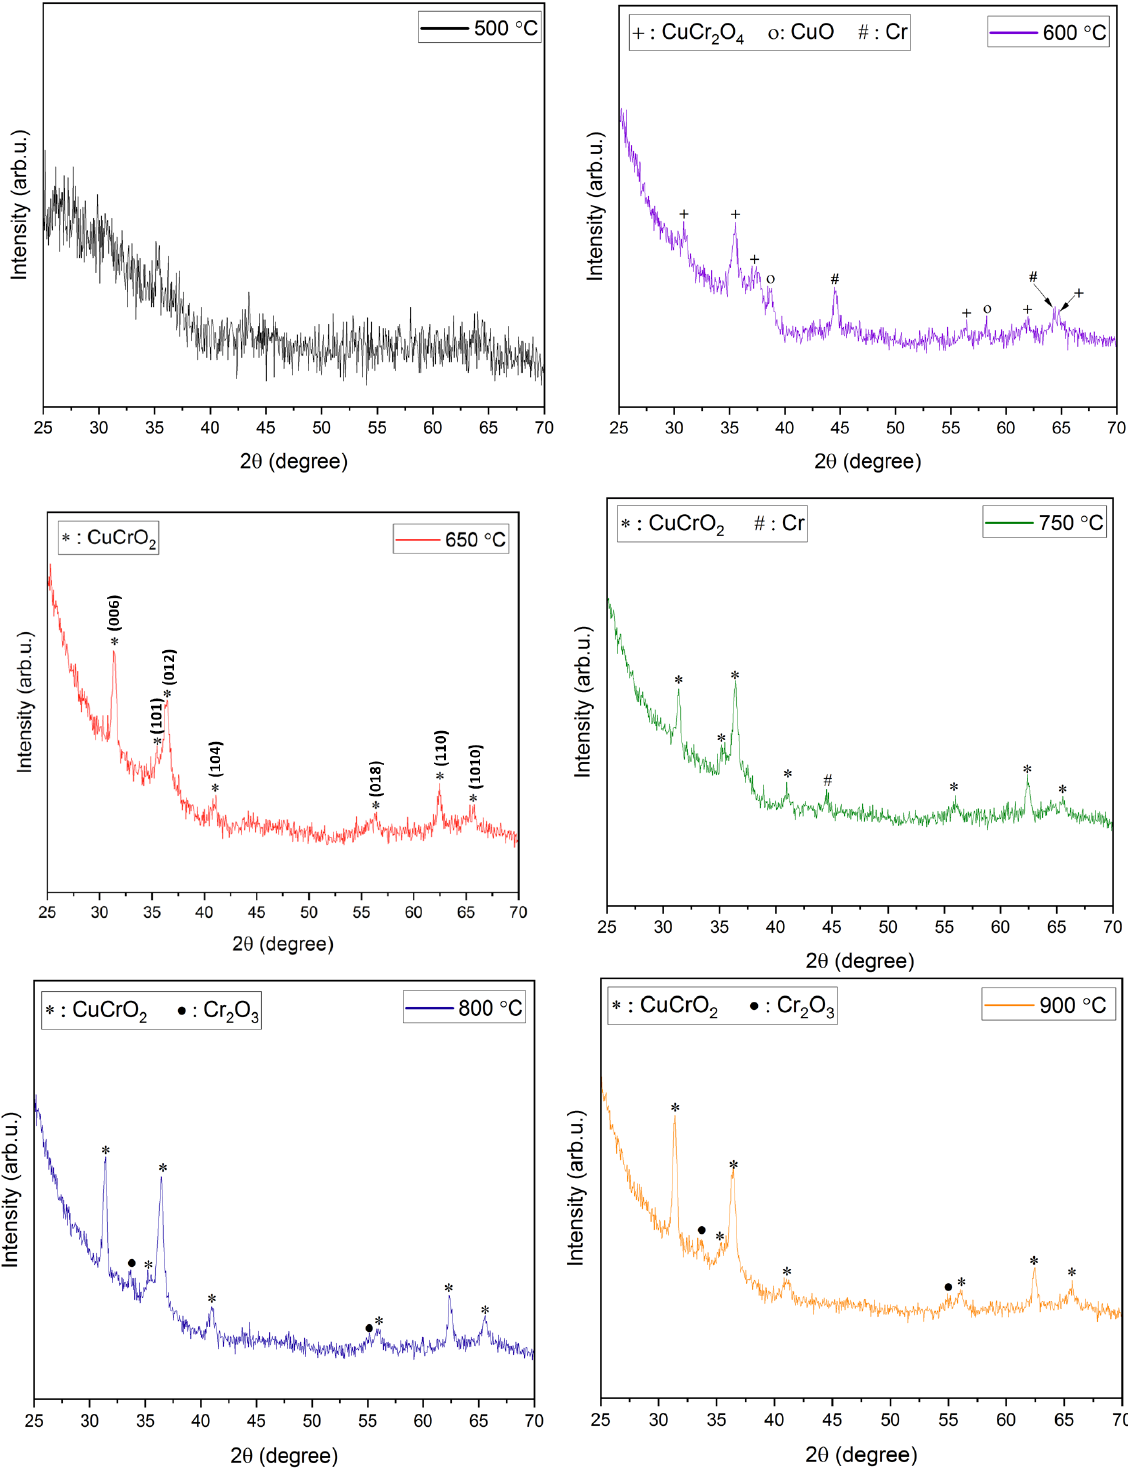
Figure 2. XRD diffractograms of films annealed at different temperatures.